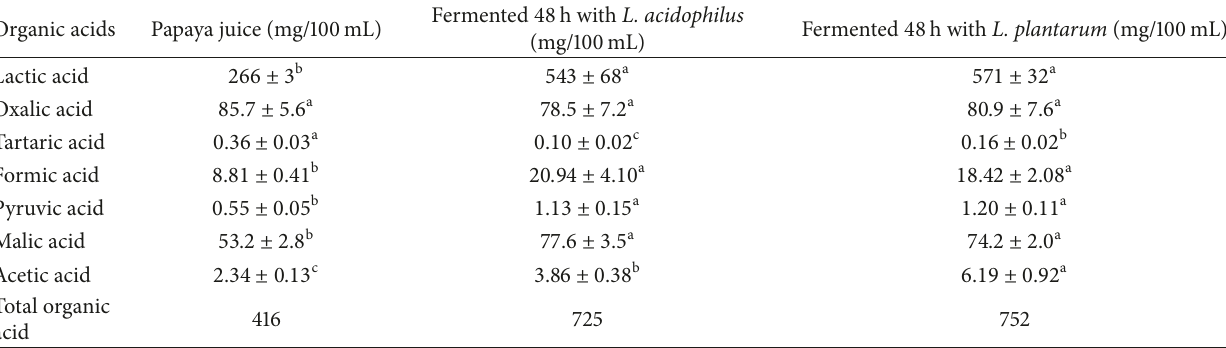
Table 4: Changes in organic acid of the fermented papaya